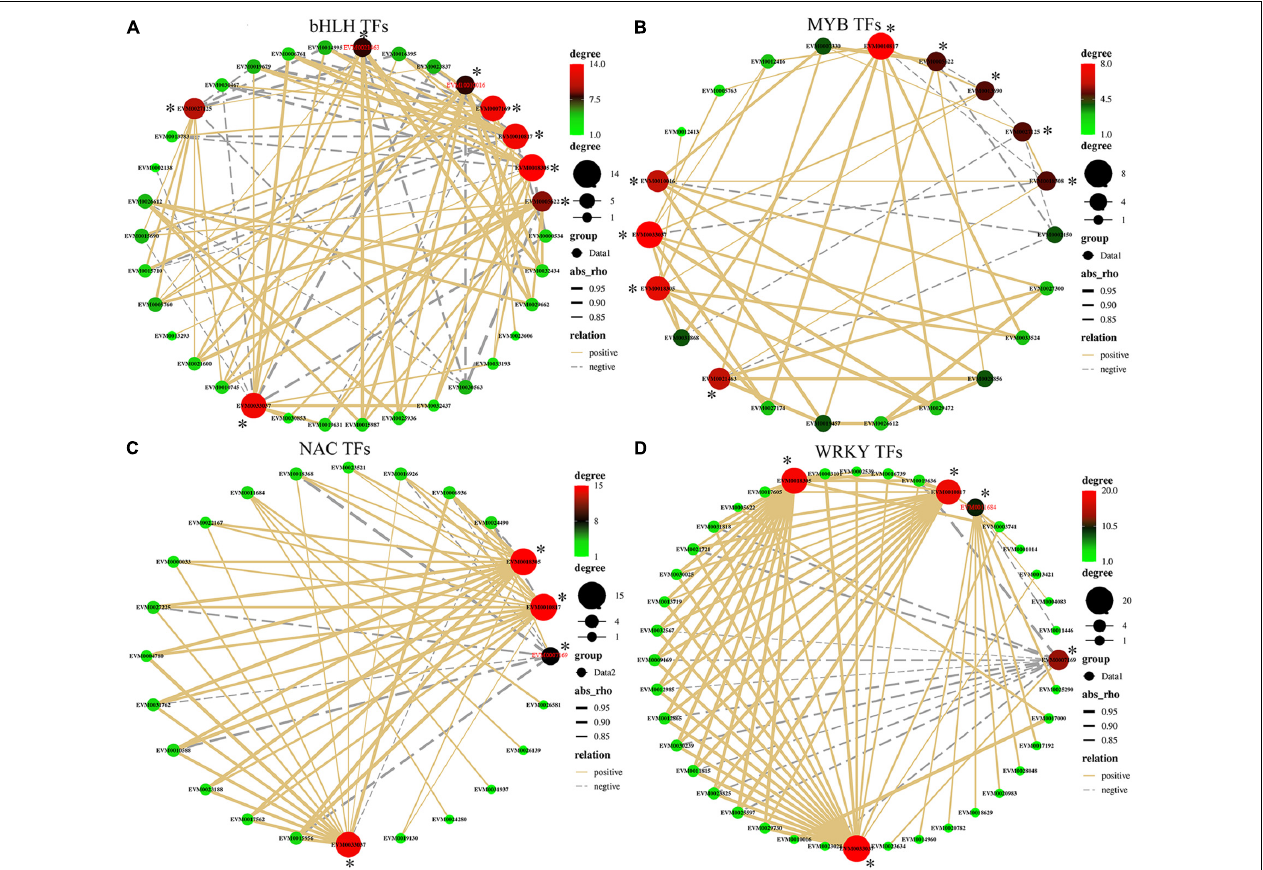
FIGURE 6 | (A – D) Correlation of gene expression between the four main DEG transcription factor (TF) families (i.e., bHLH, WRKY, NAC, and MYB) and peroxidase activity-related genes. Line color represent positive (solid yellow) and negative correlation (dotted gray); line thickness represents the strength of the correlation; dot size/color represents the number of correlated objects. ∗ represents the antioxidant